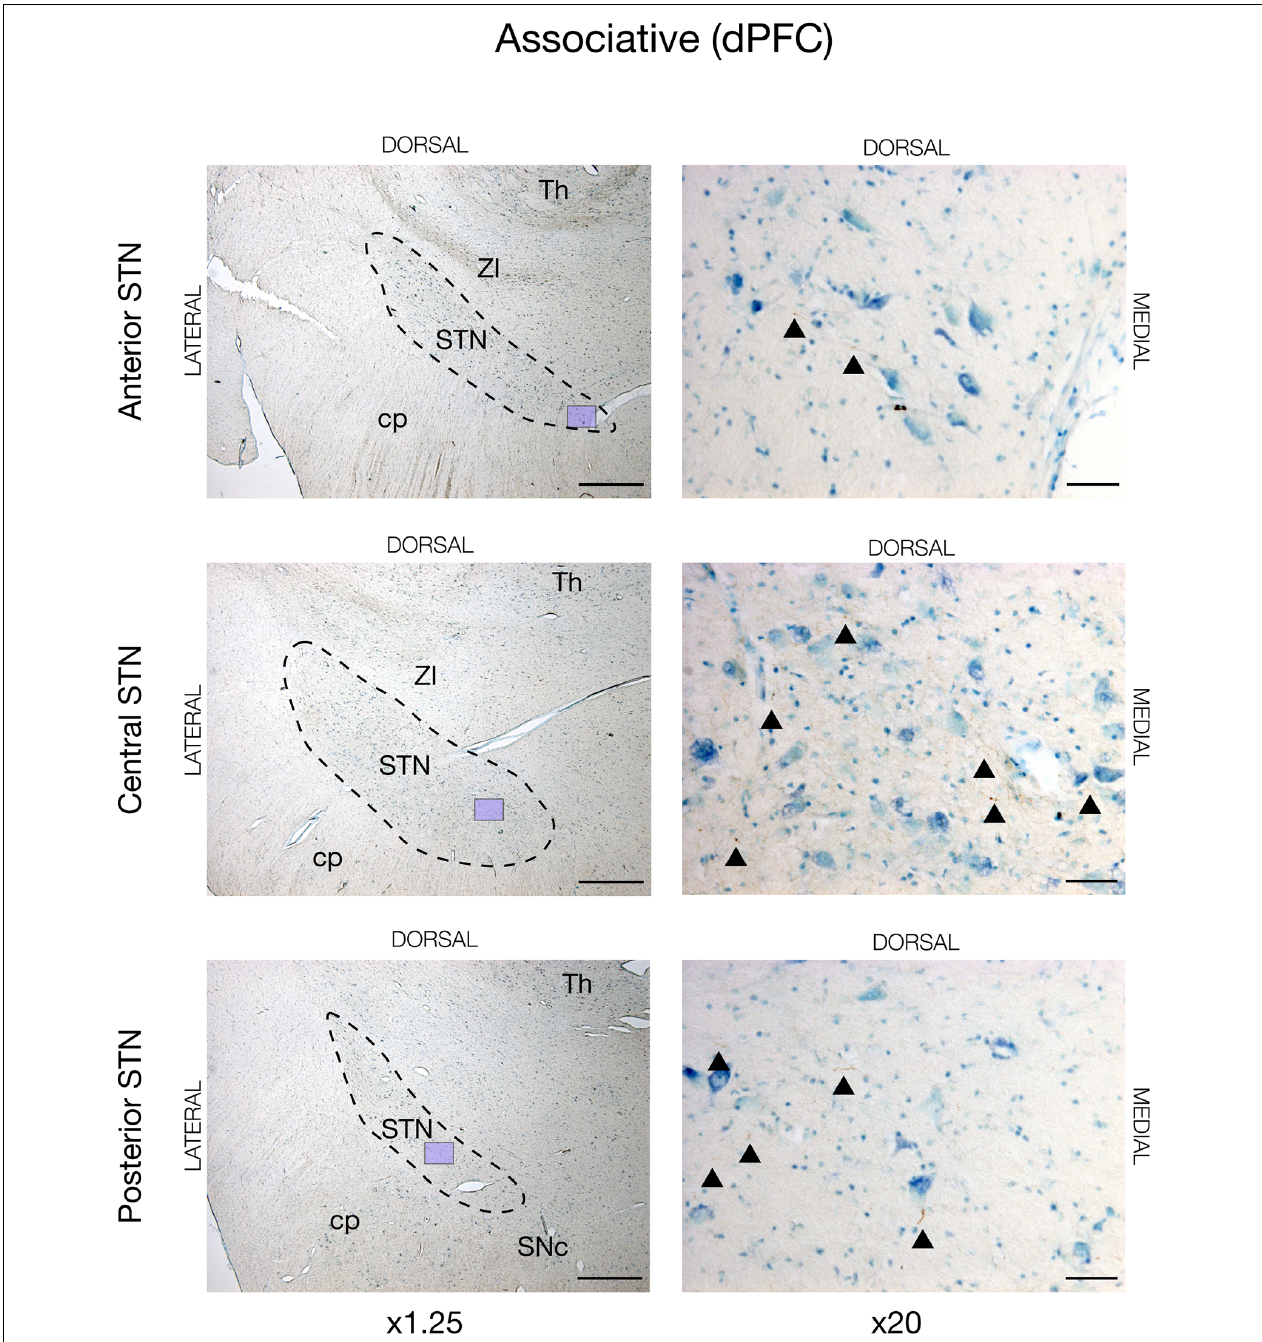
FIGURE 3 | Associative projections from the dorsal prefrontal cortex (dPFC) injected with the neuronal tracer, BDA, as seen in the subthalamic nucleus, STN (dashed lines), of JBG-2. The three rows display the anterior, central, and posterior segment, respectively, which is depicted in x1.25 magnification for overview in the left column. Colored miniature windows are showing the areas seen in detailed x20 magnification in the right column. Arrowheads mark the golden-brown traversing fibers of varying diameter. ZI, zona incerta; cp, cerebral peduncle; Th, thalamus; SNc, substantia nigra pars compacta. Counterstaining with toluidine blue. Scale bars = 1 mm (x1.25) and 50 µ m